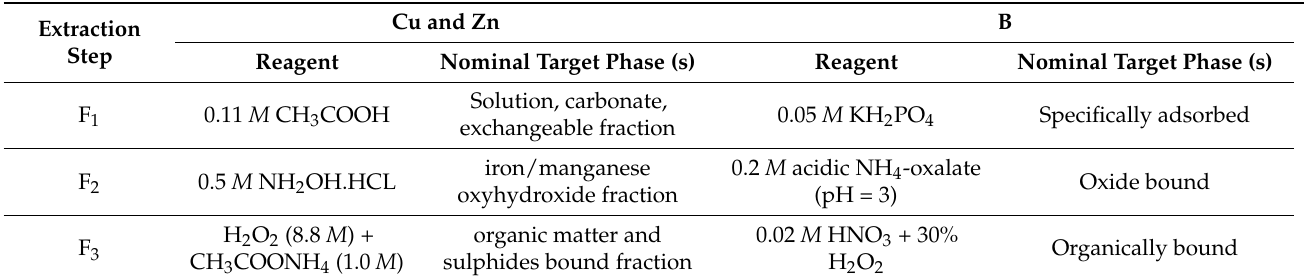
Table 2. Summary of the sequential extraction methods used for Cu, Zn, and B.